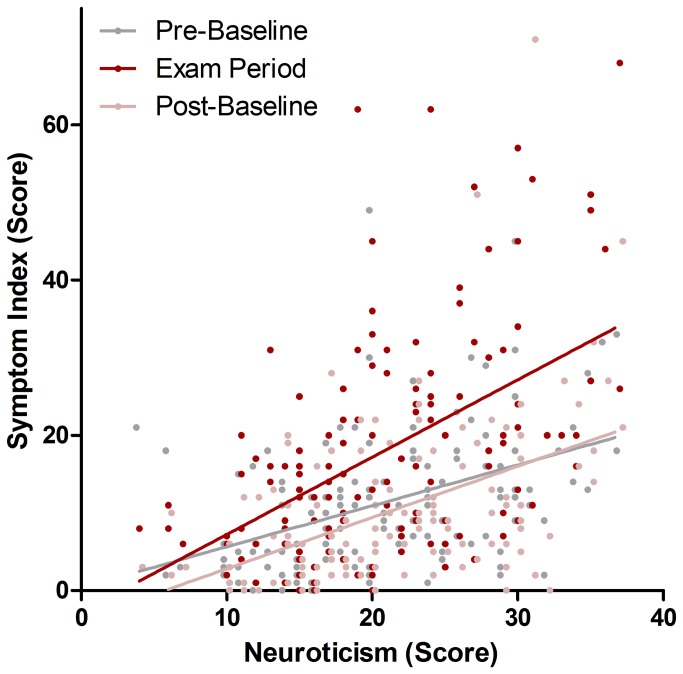
The relationship between trait neuroticism, somatic symptoms at baseline and under exam stress.There was a significant interaction between NEUROTICISM and exam period (β=0.42±0.13(SEM), t=3.30, p=.020), even when accounting for medically explained symptoms and pre-existing disorders. Raw data are shown and simple linear interpolation lines were added for illustrative purposes. To reduce overlap, data points for pre- and post- baseline were shifted by -0.5 and +0.5 points along the x-axis, respectively,